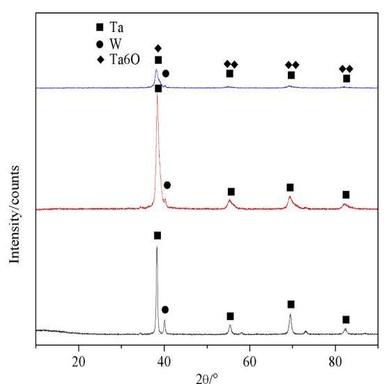
XRD of Ta10W side for TY-3-2 under different conditions. (a)after ablation, (b)before ablation, (c)raw powder.